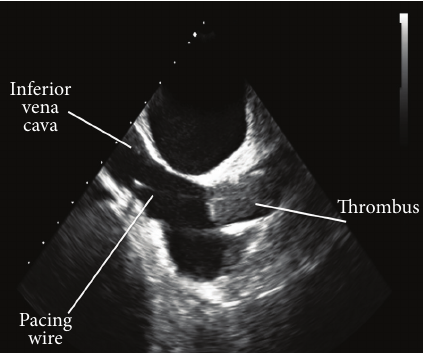
Figure 1: Transesophageal echocardiogram demonstrating a large thrombus in the superior vena cava. The pacing wire appears to overlay the thrombus. Because this is a 2D image, hence no spatial depth, it is unclear if there is a space between the thrombus and wire or whether it is independent of